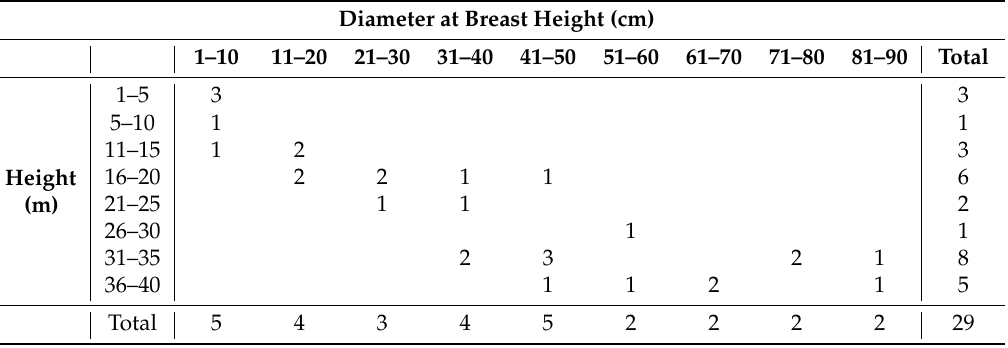
Table 3. Distribution of candidate trees by diameter and height class, which were used to predict the biomass and other tree components for coast redwood ( Sequoia sempervirens ) on industrial